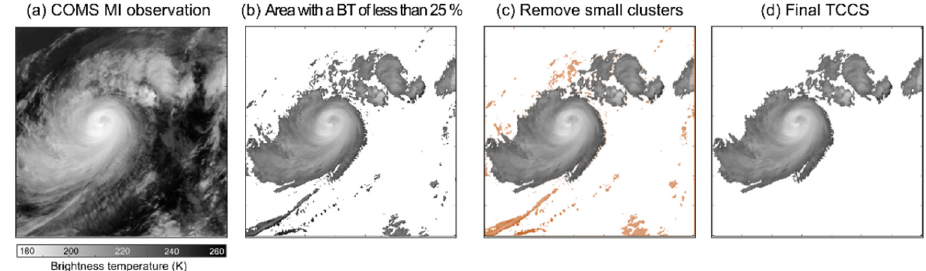
Figure 4. Pre-processing to extract a tropical cyclone cluster system (TCCS) using Communication, Ocean and Meteorological Satellite Meteorological Imager sensor observation at 0600 UTC on 15 October 2017 as an example. ( a ) Brightness temperature (BT)-based infrared image observed from Communication, Ocean and Meteorological Satellite Meteorological Imager. ( b ) Deep convective region with a BT below the 25% quantile in the interest region. ( c ) Excluding the three largest clusters, the orange-colored clusters represent small fragmented clusters. ( d ) The extracted TCCS.